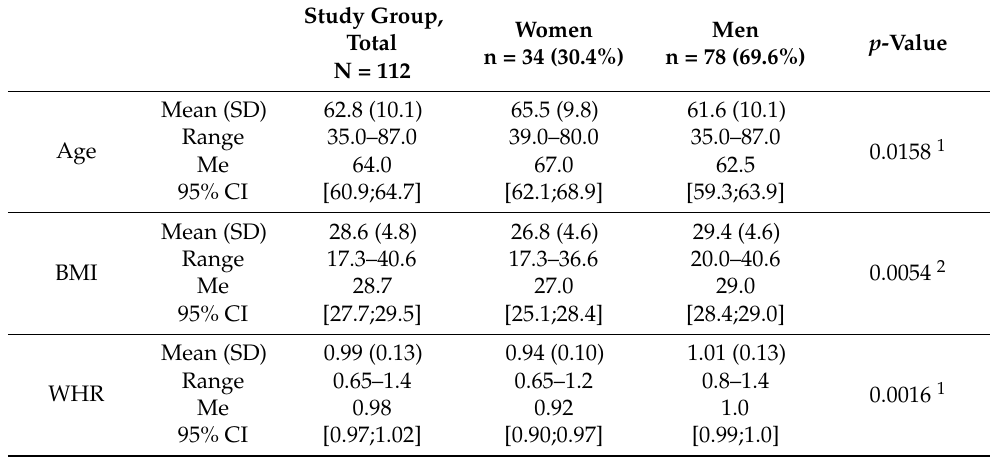
Table 2. Characteristics of the study group.